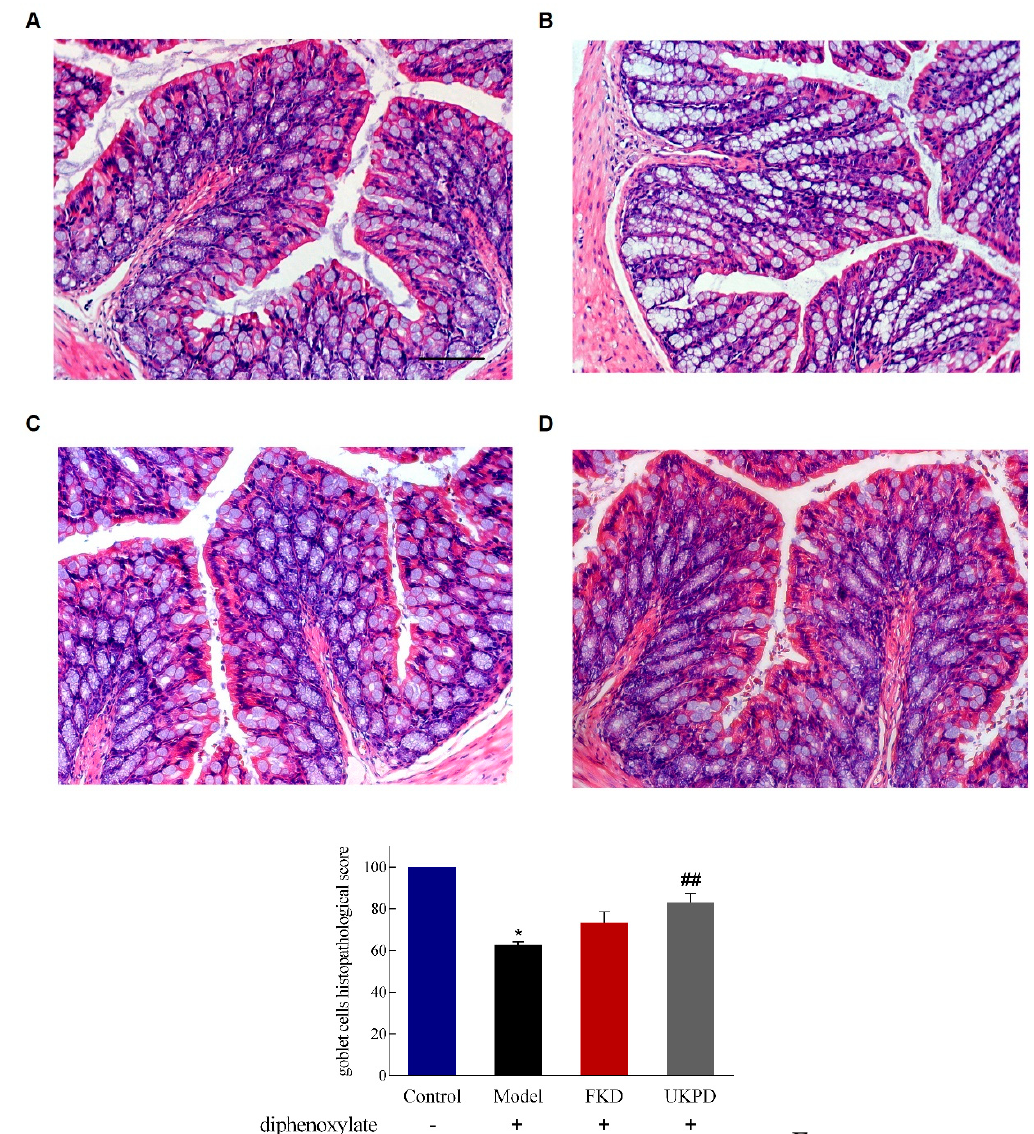
Figure 3. Effects of UKP and FKD on preventing intestinal damage. Representative photomicrographs of hematoxylin and eosin (H&E) staining of jejunum in ( A ) control group, ( B ) model group, ( C ) FKD group, and ( D ) UKPD group. Scale bars: 200 µ M. ( E ) Goblet cells histopathological score.